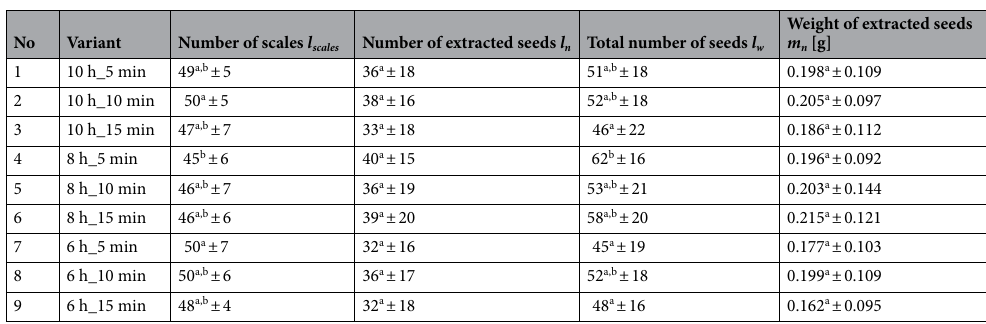
Table 6. Mean numbers of cone scales and seeds for each process variant. a, b – homogeneous groups.